Question: Write the caption for this figure.
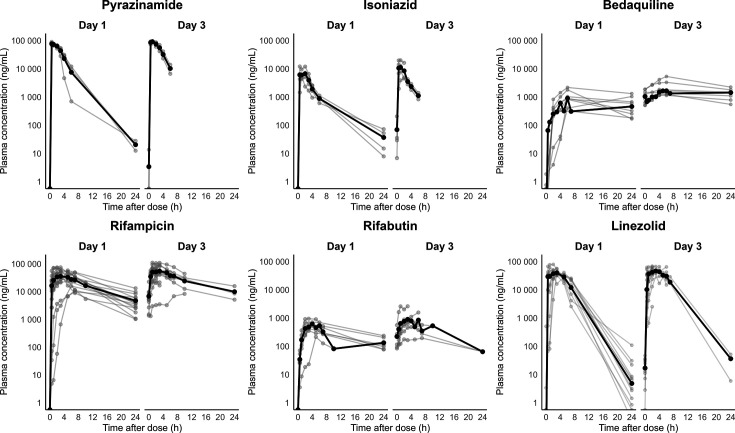
Answer: Dosing regimens and corresponding human-equivalent doses for each experiment